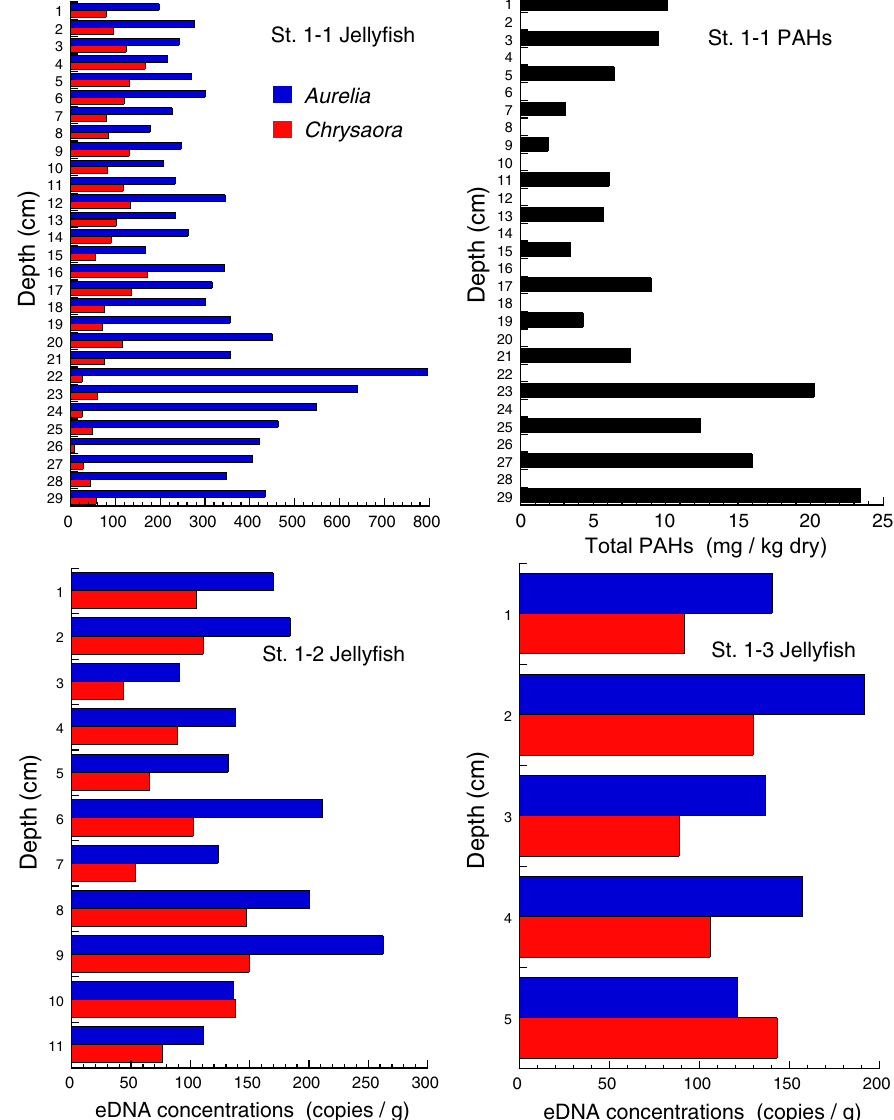
Figure 5. Concentrations of moon jellyfish ( Aurelia sp.) and sea nettle ( Chrysaora pacifica ) eDNA and polycyclic aromatic hydrocarbons (PAHs) analyzed from samples of the sediment cores collected at St. 1 in Moune, Kesennuma, northeast Japan. Three cores were analyzed for jellyfish eDNA, whereas PAHs were analyzed only for the longest one (Core St.